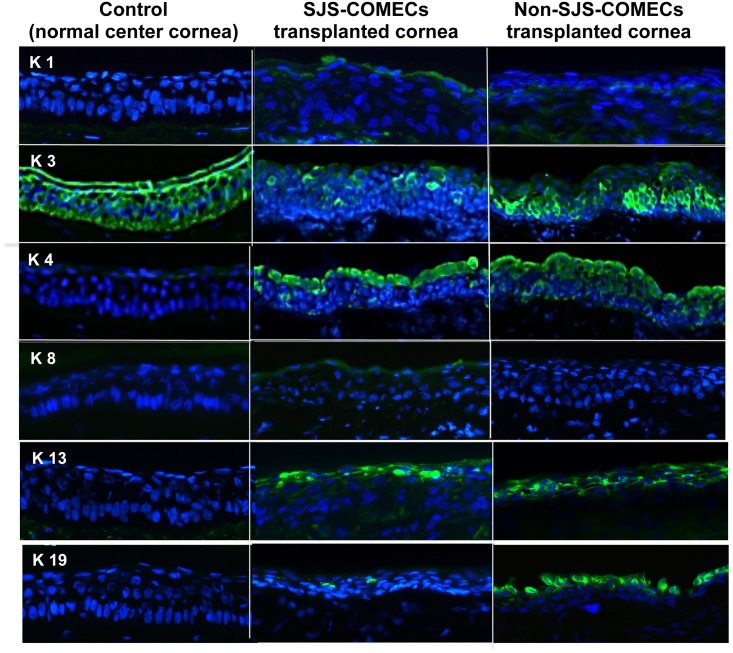
Epithelial characteristics of the ocular surface transplanted with Stevens—Johnson syndrome (SJS) and non-SJS COMECs on day 7 post-transplantation.Corneas with COMECs from both SJS and non-SJS subjects expressed K3, K4 and K13 (X200). K1 and K8 were not expressed in both groups. K19 was expressed in cornea transplanted with non-SJS COMECs, and it was barely expressed in cornea transplanted with SJS COMECs. The control indicates a normal center cornea.